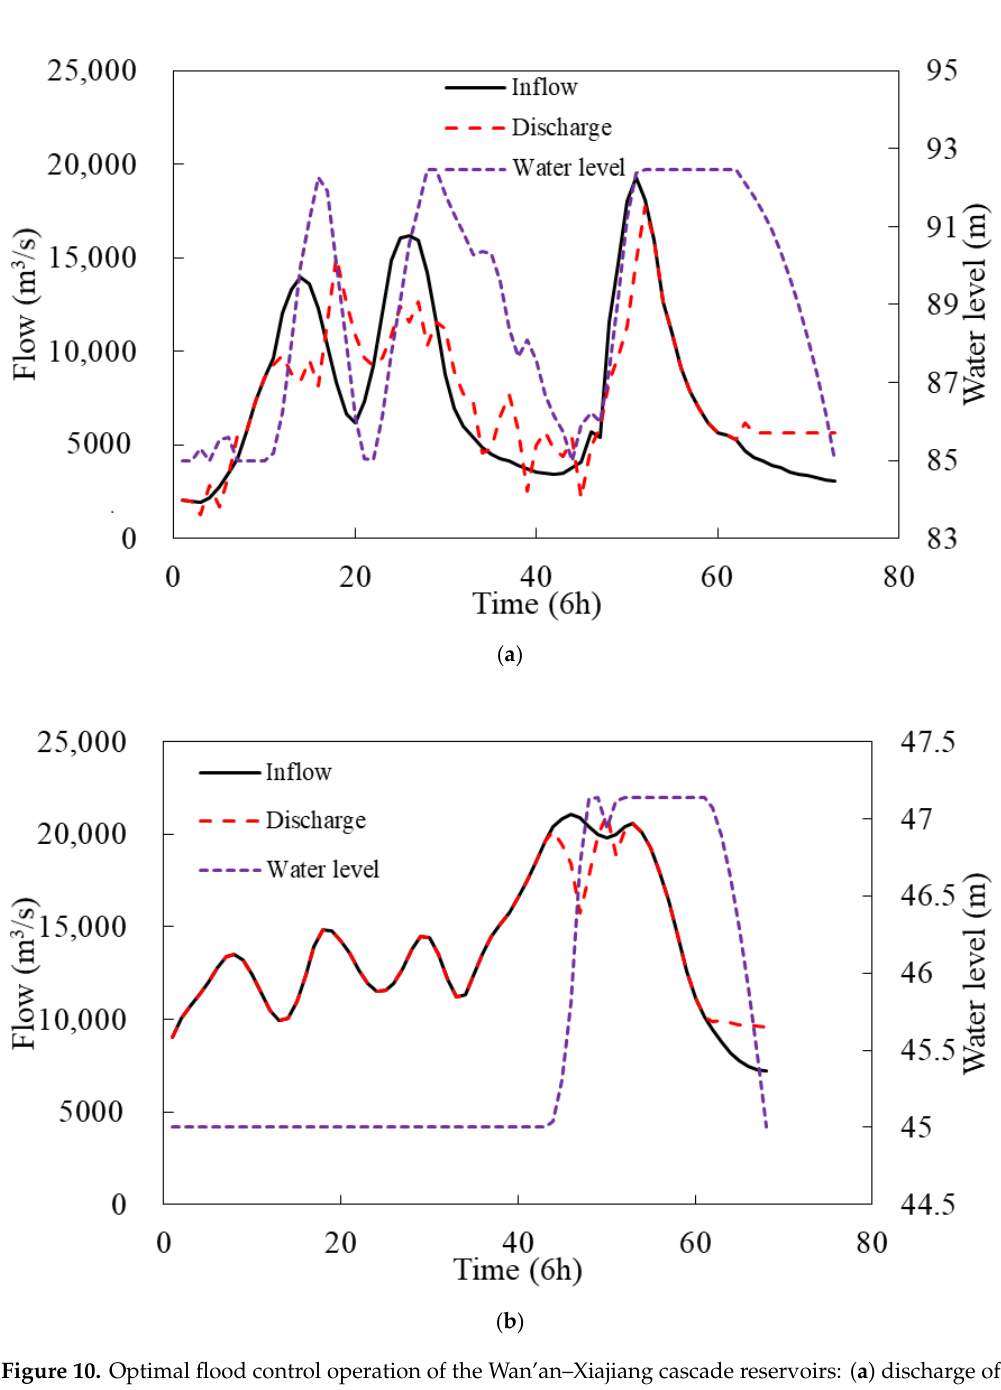
Figure 10. Optimal flood control operation of the Wan’an–Xiajiang cascade reservoirs: ( a ) discharge of the Wan’an reservoir; ( b ) discharge of the Xiajiang reservoir. the Wan’an reservoir; ( b ) discharge of the Xiajiang